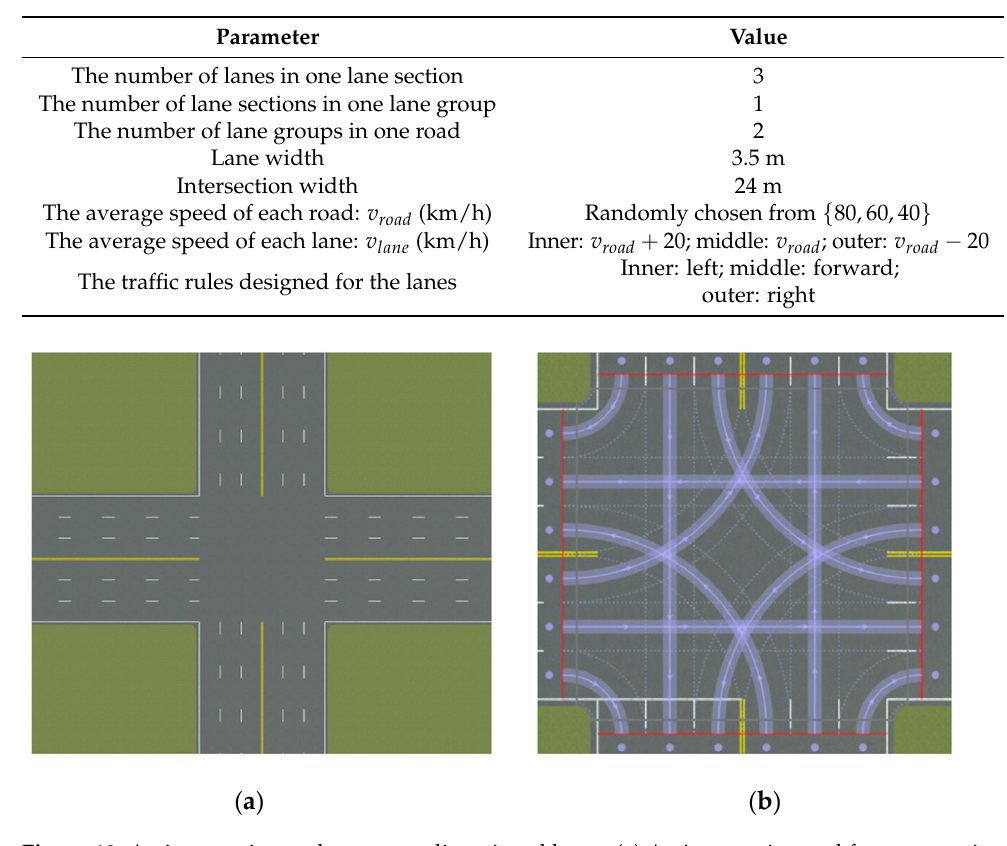
Figure 10. An intersection and corresponding virtual lanes. ( a ) An intersection and four connecting roads are shown. ( b ) The virtual lanes in the intersection shown in ( a ) are displayed.